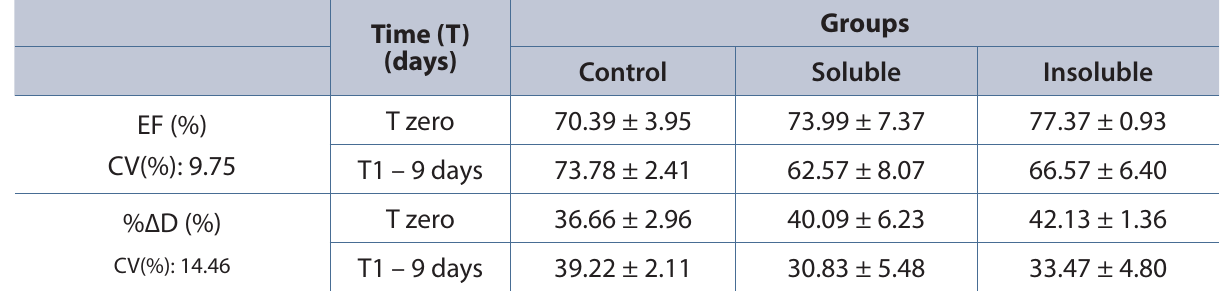
Table 9. Mean of the systolic shortening percent* (%∆D - %) and ejection fraction * (EF - %) of the left ventricle of rabbits submitted to gavage with ultra-pure water (CG), water-soluble A. rigida extract (SG) and water-insoluble A. rigida extract (IG) at different